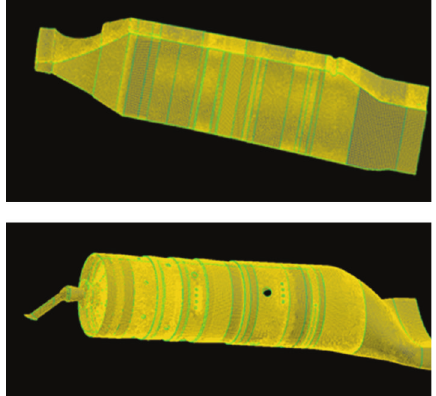
Figure 4: Meshes of 60-degree annular chamber and a combustor